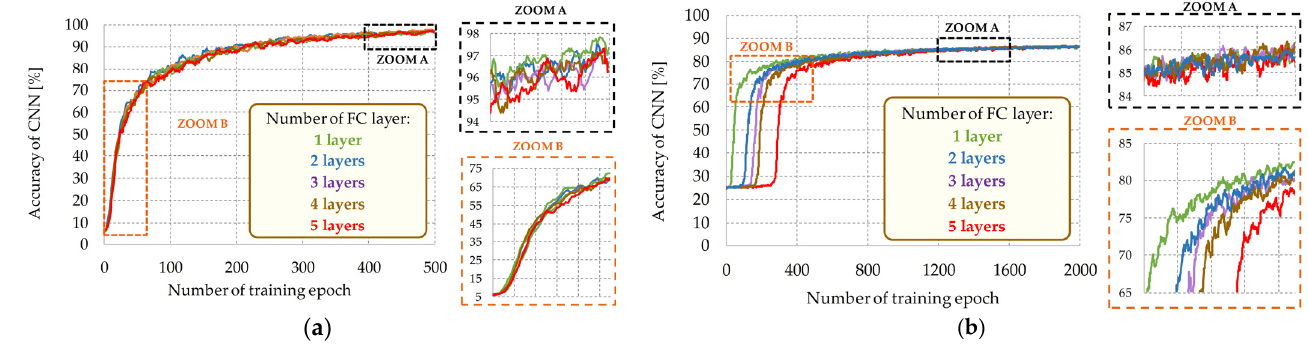
Figure 8 . Influence of the number of fully connected layers on the precision of the CNN network— learning curves: ( a ) induction motor; ( b ) PMSM.